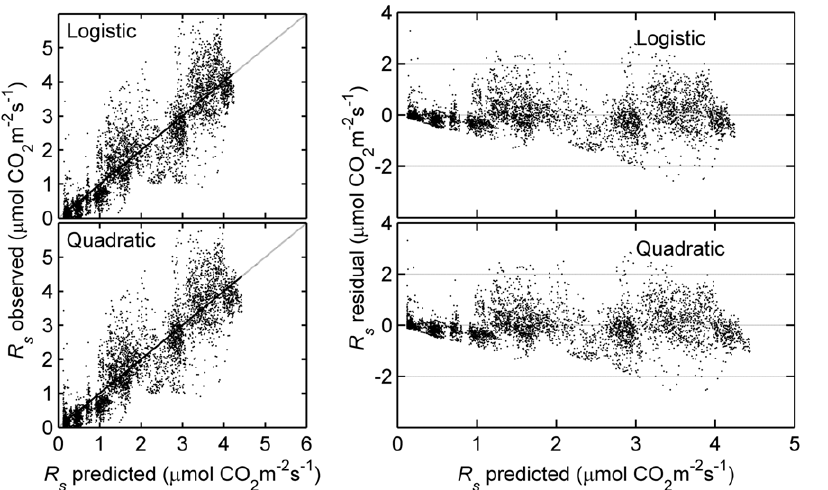
Figure 3. Comparison of measured hourly soil respiration ( R s ) as a fuction of modeled values using logistic and quadratic model for 2008.